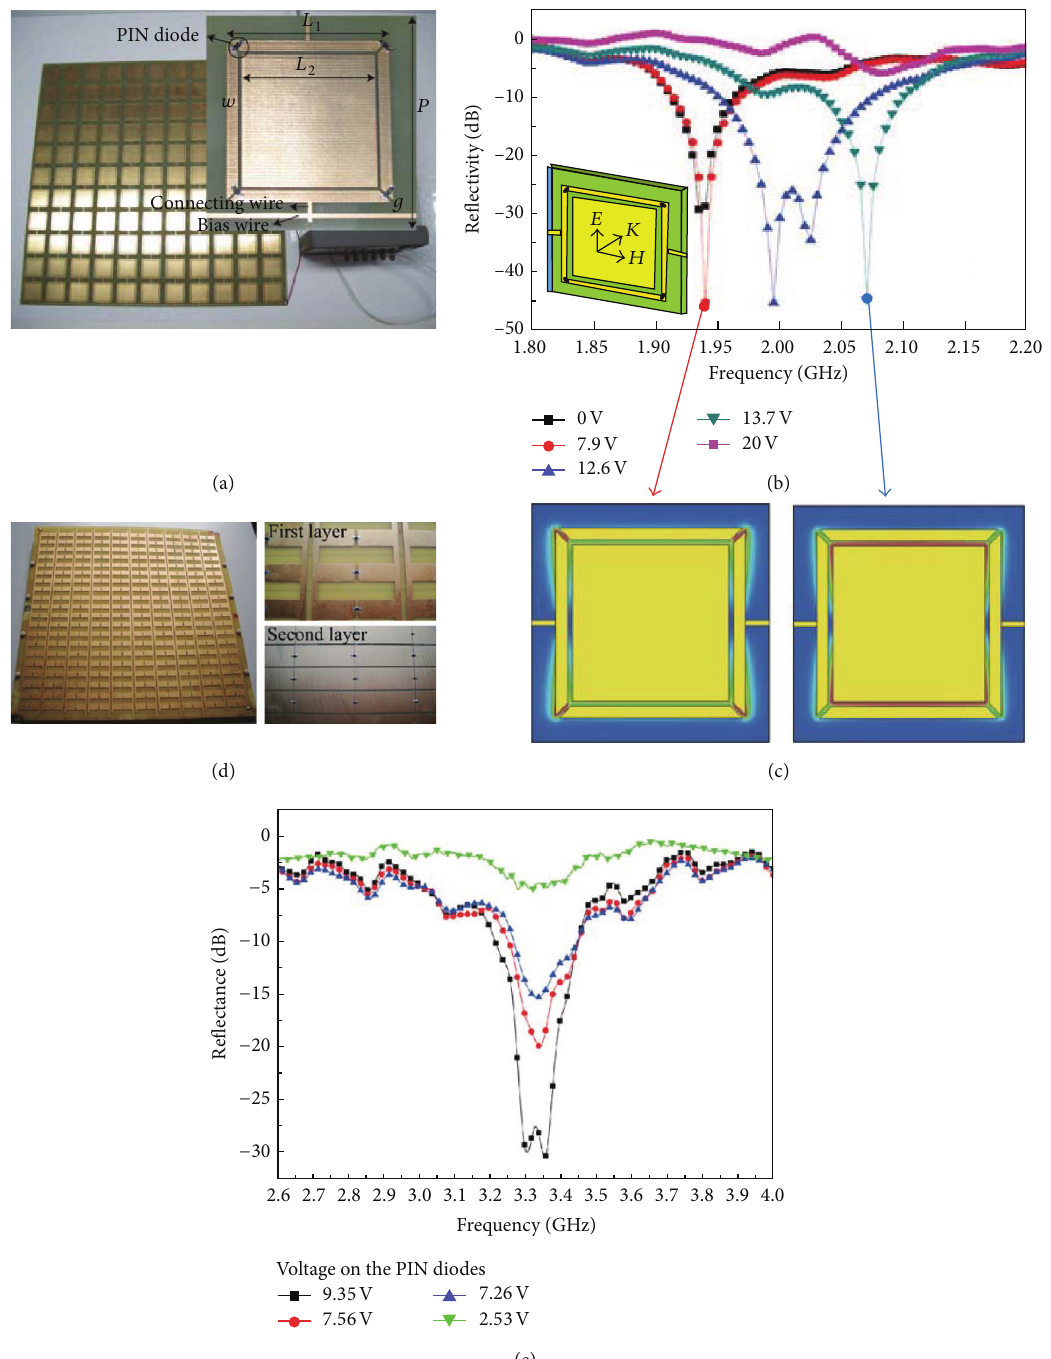
Figure 45: (a) Configuration of tunable absorbing material. (b) Measured reflectivity at different bias voltages under incident angle of 15 ∘ , and the power loss density at two frequencies is shown in (c). (d) Photograph of the fabricated active absorber; the measured sample has an area of 340 × 340 mm 2 , consisting of 200 units. Varactor and pin diodes are assembled through hand-soldering techniques. (e) Measured reflectance spectra of the active absorber with different bias voltages applied upon PIN diode. Figures are reproduced from [228,